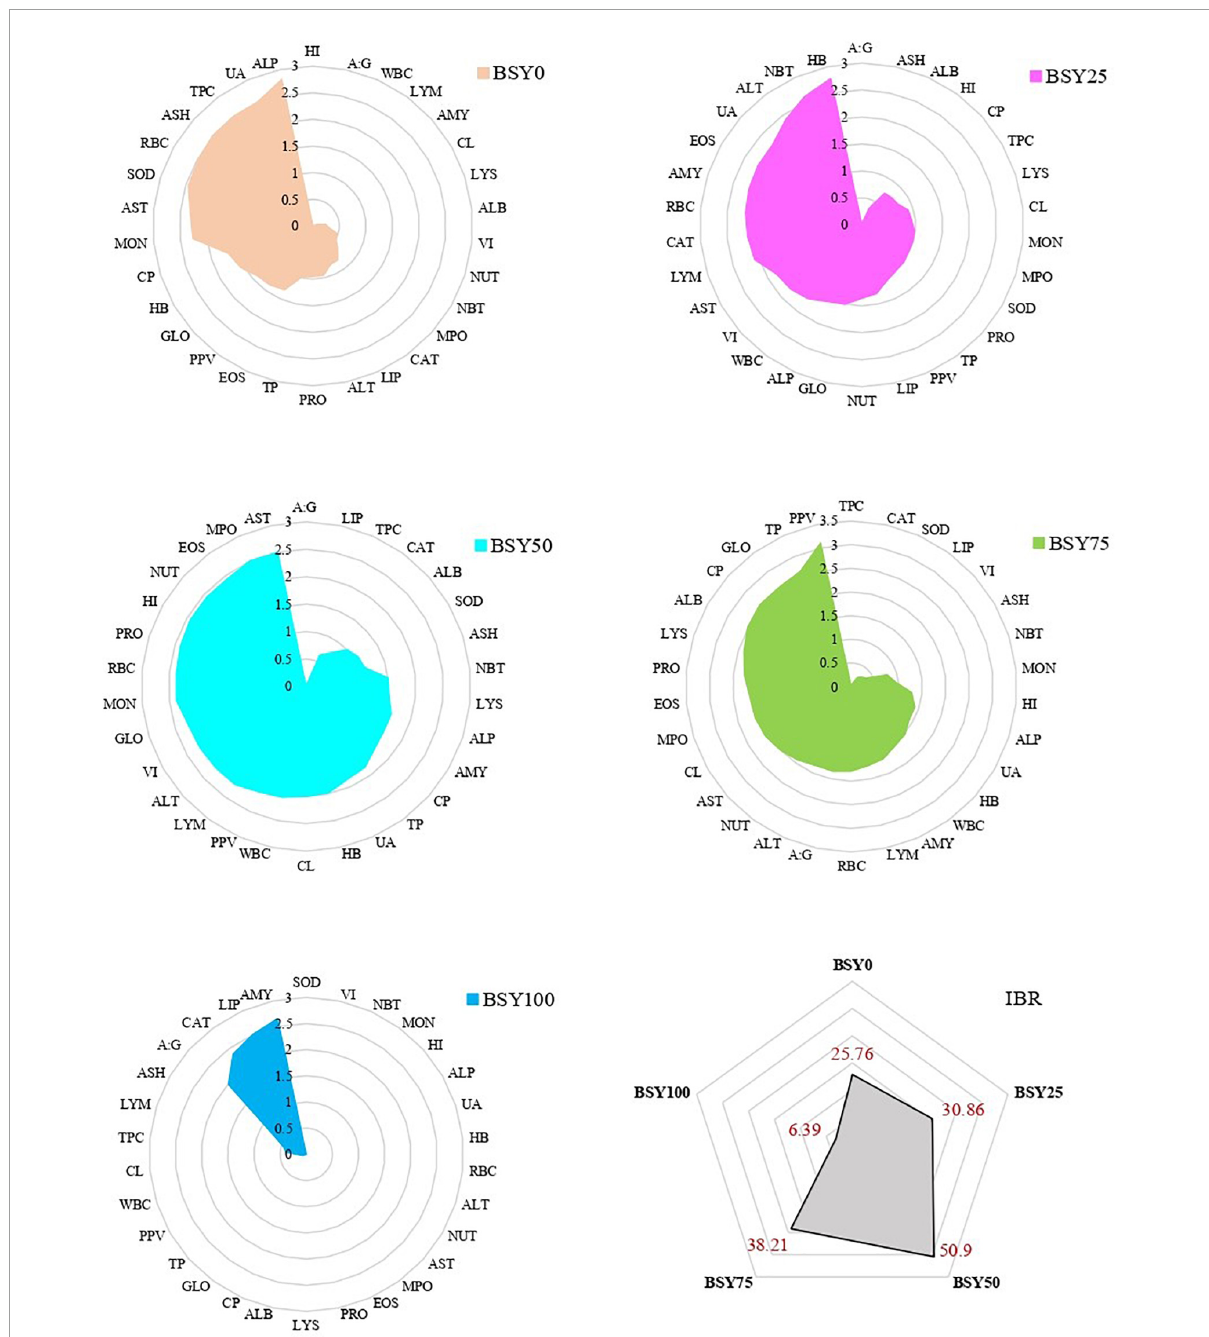
FIGURE8 Integrated biomarkers responses (IBR) of climbing perch fingerlings fed with BSY incorporated diet for 60 days.